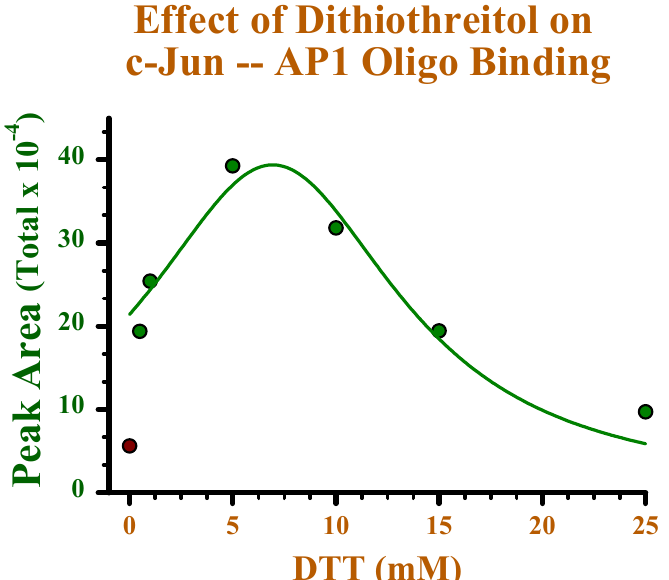
Figure 4. Dithiothreitol (0 - 25mM) was included in a 37º C, 15 min incubation with 21 pmol c-Jun prior to incubation with 250 pmol AP-1 oligonucleotide at 37º C, 2 h. Increased protein binding occurred at DTT concentrations from 0 to 5 mM, and then decreased at higher DTT